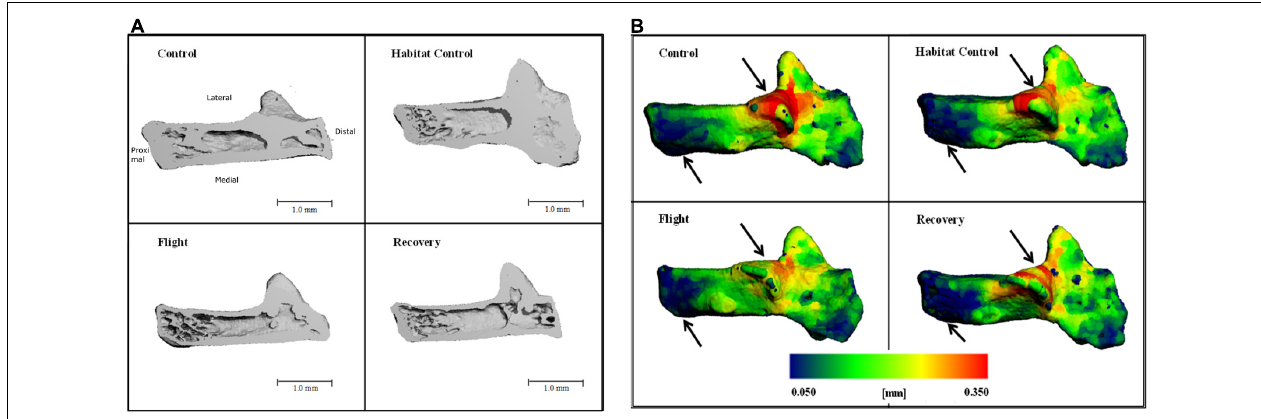
FIGURE 3 | Three-dimensional reconstructions of the calcaneus, illustrating (A) cross-section through 3D reconstructions of calcaneus: Control; Habitat control; Flight; Recovery. (B) Color maps for Ct.Th of calcaneus; blue = thinnest (0.050 mm) and red = thickest (0.350 mm) for: Control; Habitat control; Flight; Recovery. Black arrows indicate areas of greatest change at